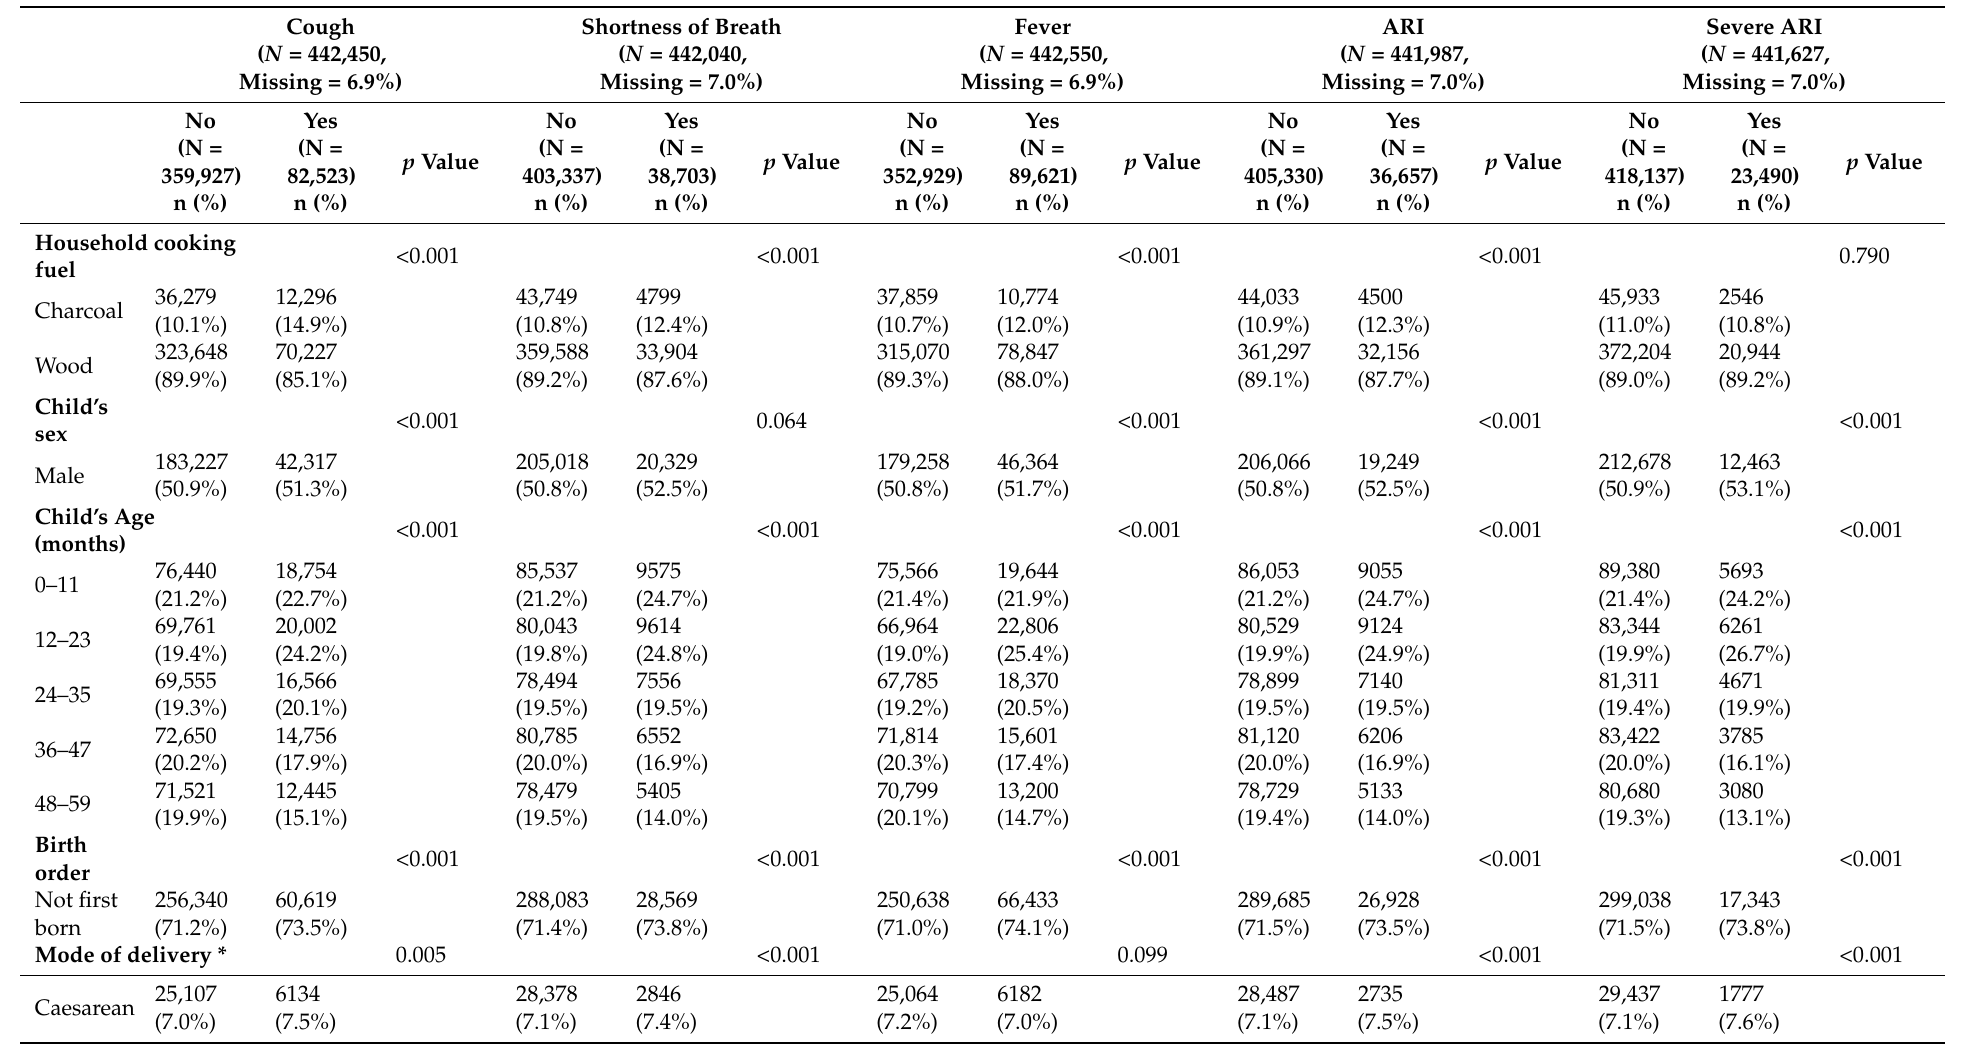
Table 1. Descriptive statistics before imputation for respiratory health outcomes (N =